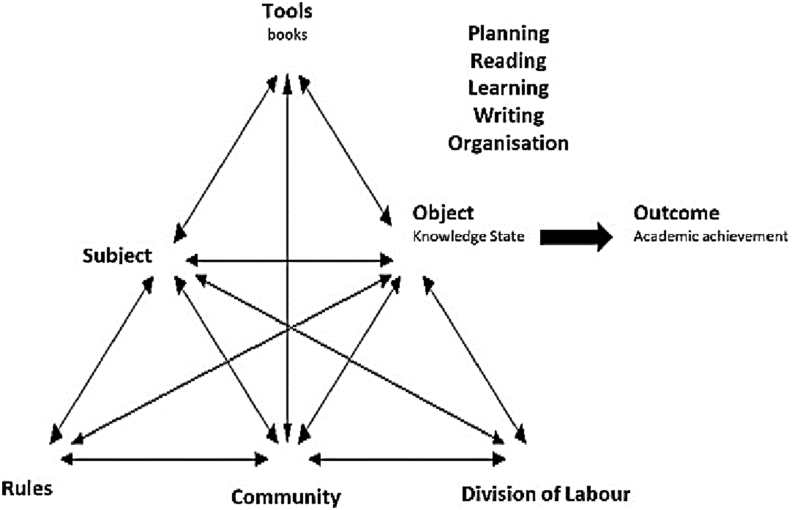
Activity Theory model of Academic Work. Adapted under CC-by-SA-3.0 (Bury, 2012).